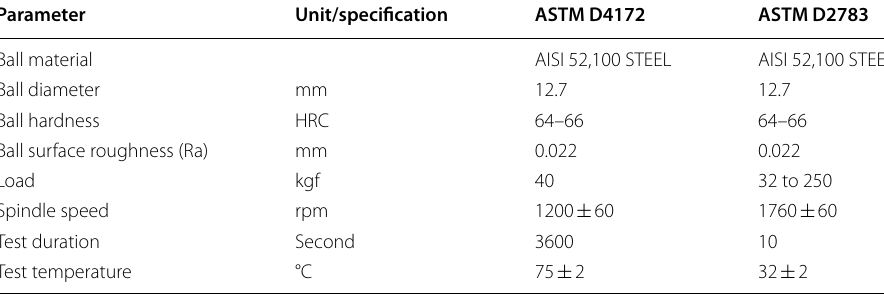
Table 2 Test conditions of four-ball